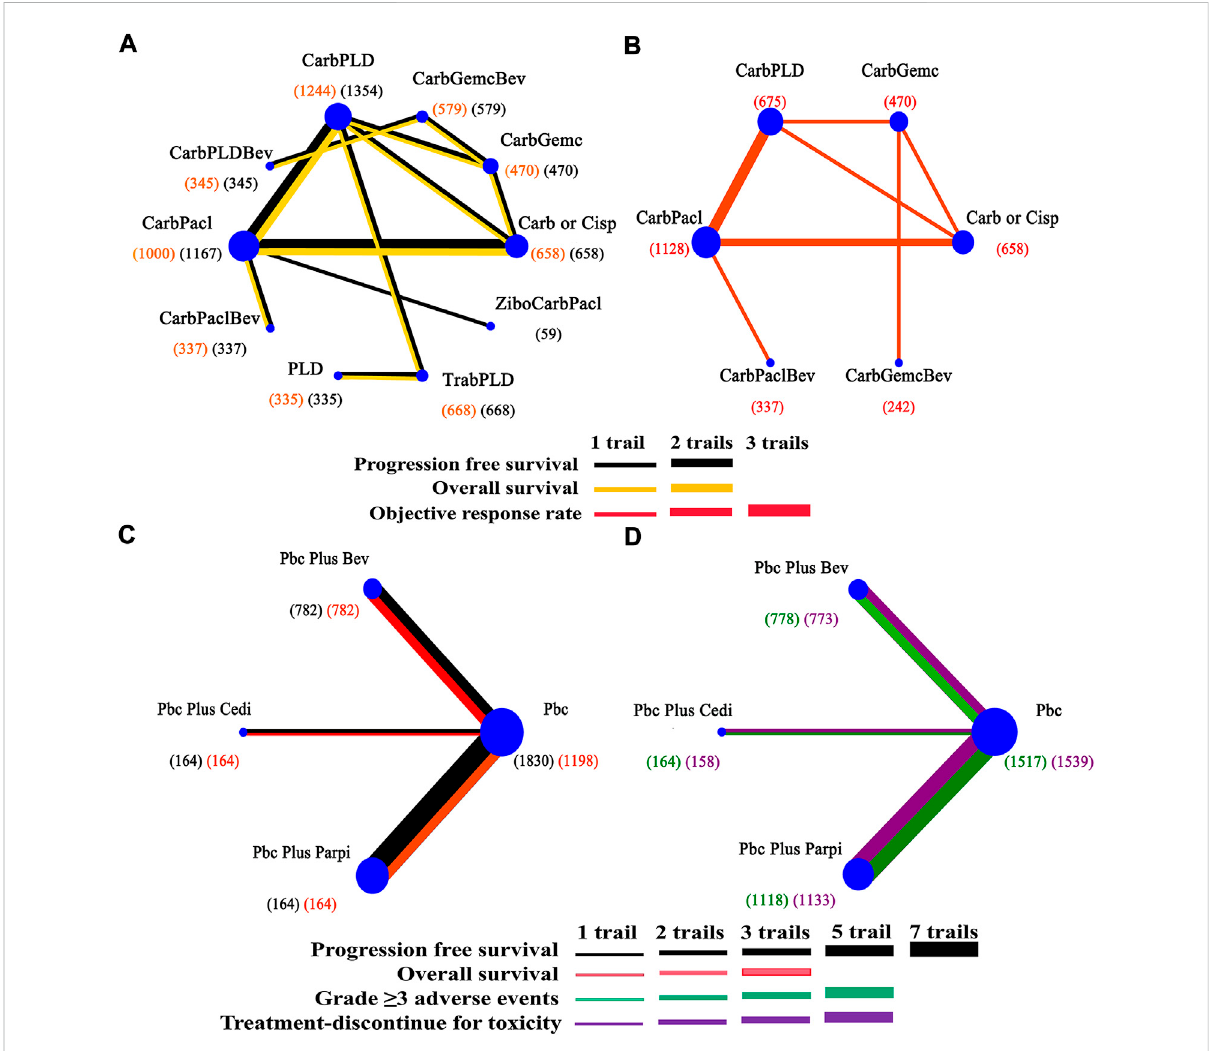
FIGURE 3 NetworkofinterventionaltreatmentsintheBayesiannetworkmeta-analysis. (A) Comparisonsonprogressionfreesurvivalandoverallsurvivalin patients with platinum-sensitive ovarian cancer. (B) Comparisons on objective response rate. (C) Comparisons on progression-free survival and overallsurvivalinmaintaintherapy. (D) Comparisonsonadverseeventsofgrade3orhigherinmaintaintherapy.Thesizeofeachcircleisproportional to the total number of patients receiving a treatment. The width of lines is proportional to the number of studies comparing the connected